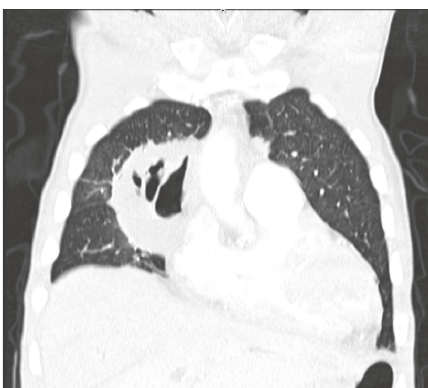
Figure 1: CT of the chest revealing a large right middle lobe cavitary mass ( 6.5 ∗ 7.6 ∗ 8.1 cm 3 ) with bilateral pulmonary nodules and a small pericardial effusion.